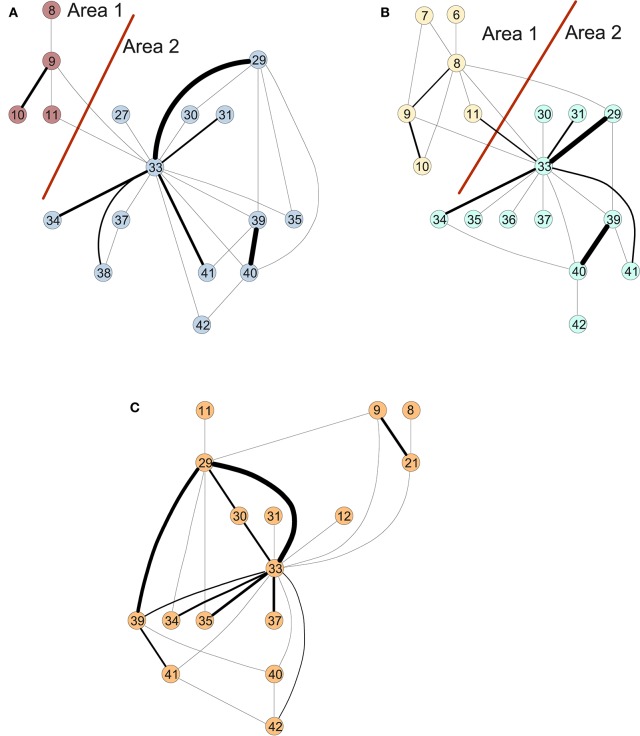
Areas of the connectivity graph for structural data for (A) controls, (B) MCI, and (C) AD.